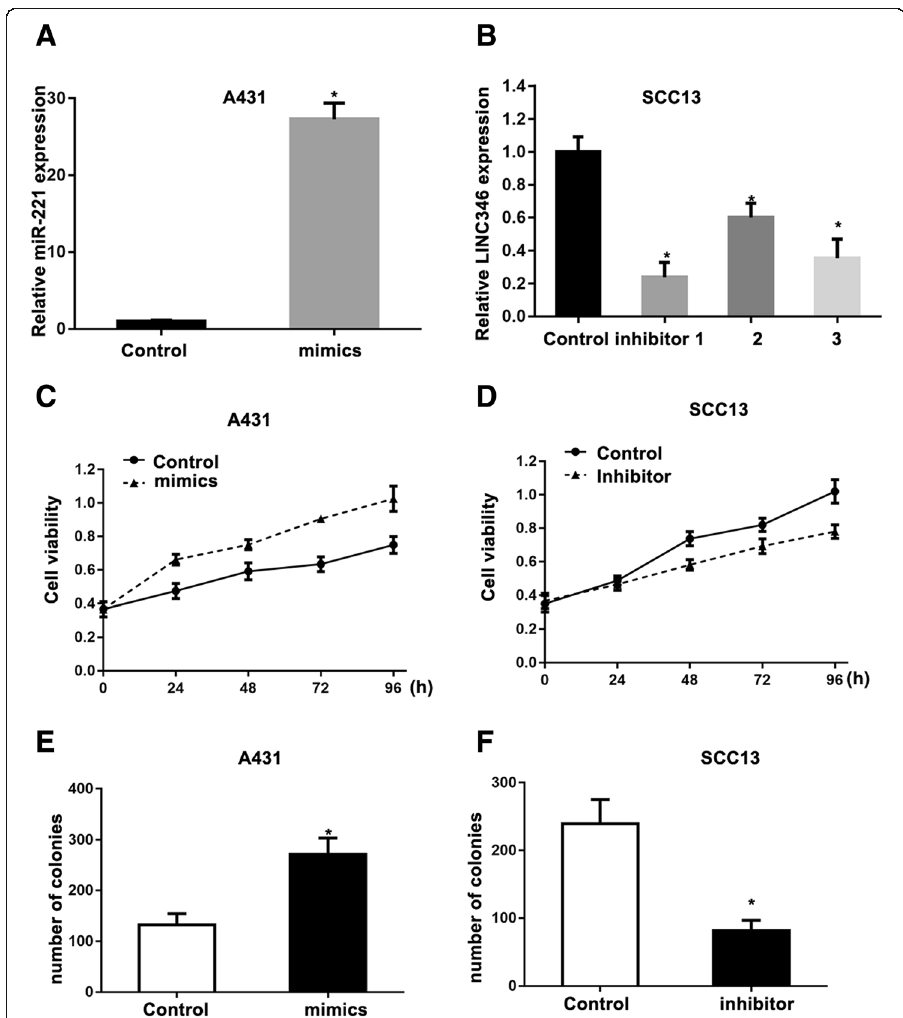
Fig. 2 miR-221 regulates cell proliferation in CSCC. Expression level of miR-221 in cells after transfection with miR-221 mimics ( a ) and inhibitors ( b ), as detected by quantitative RT-PCR. miR-221 overexpression ( c ) or silencing ( d ) regulated cell viability in cells at 24, 48, and 72 h by MTT assay. Quantitative results of colony formation assay in A431 ( e ) and SCC13 ( f ) cells transfected with miR-221 inhibitor or mimic, respectively. * P < 0.05, compared with control